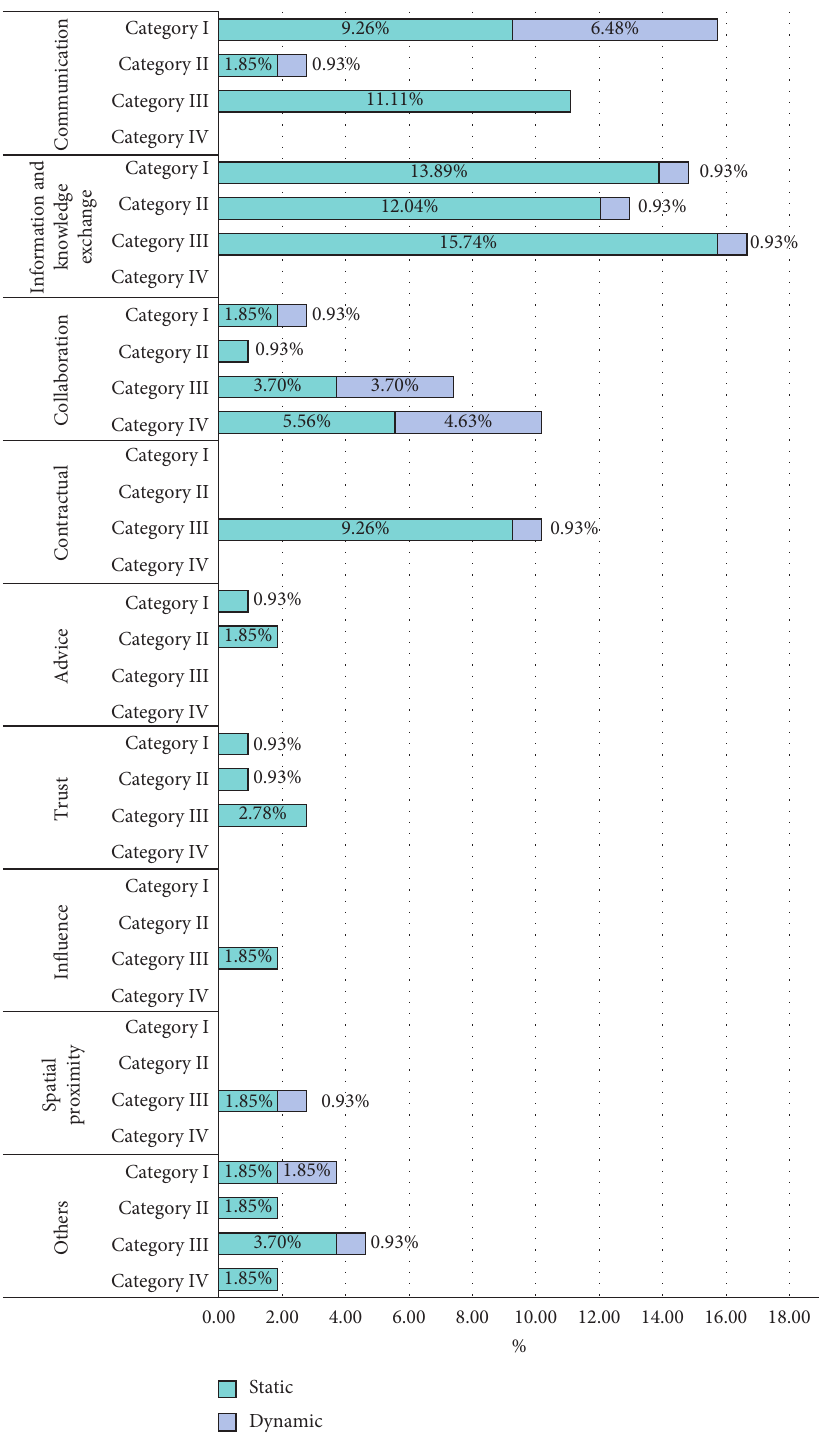
Figure 5: Distribution of publications by types of network